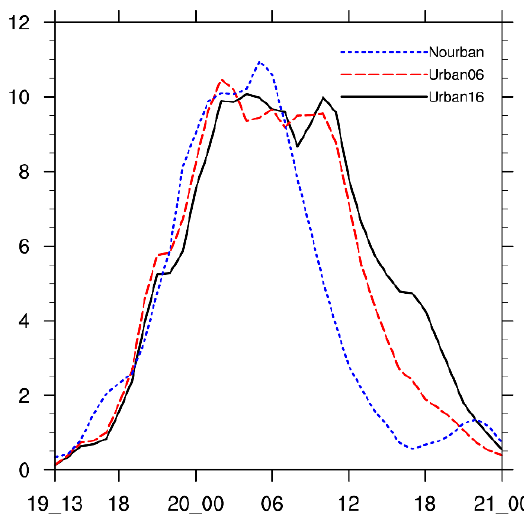
Figure 5. Changes in average precipitation over time for the D3 region for the three experiments from 13:00 UTC 19 July 2016 to 00:00 UTC 21 July 2016 (units: